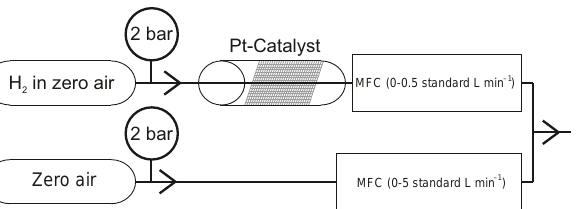
Figure 3. Setup of the in-flight calibration: (a) zero air can be added to the sample flow for dilution and background measurements. (b) A mixture of H 2 in zero air is passed over a heated Pt-catalyst and re- acts to H 2 O for calibration of the water vapor configuration. The water vapor mixing ratio in the calibration gas can be further ad- justed by dilution with synthetic air from (a) . To allow for equili- bration of the catalytic source, the calibration gas flow is switched on early and guided to the exhaust line before starting a calibration sequence.